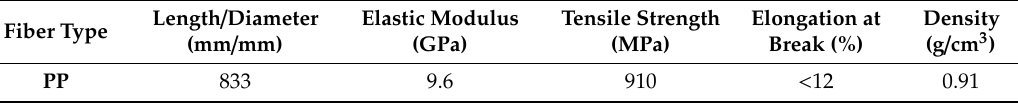
Table 2. The physical and mechanical properties of the PP fiber [40].